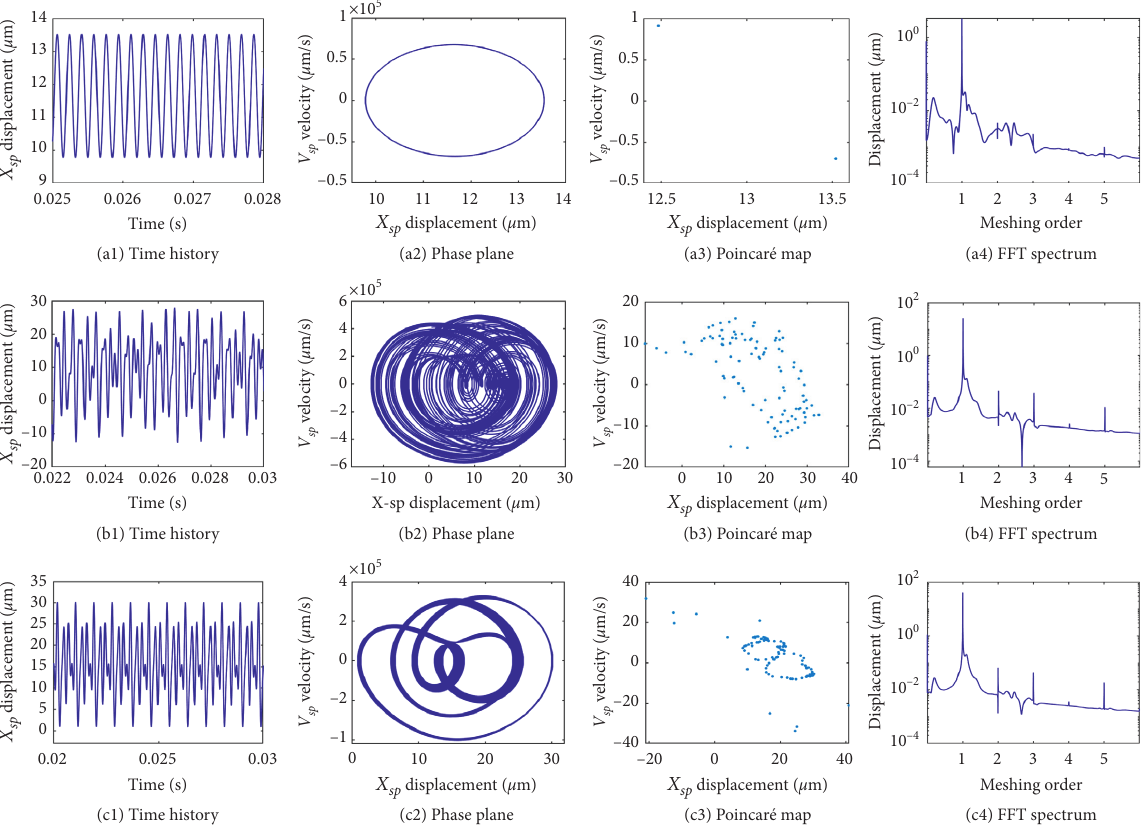
Figure 14: Vibration response of sun gear and star gear meshing pair. (a) E � 3, (b) E � 5, (c) E �